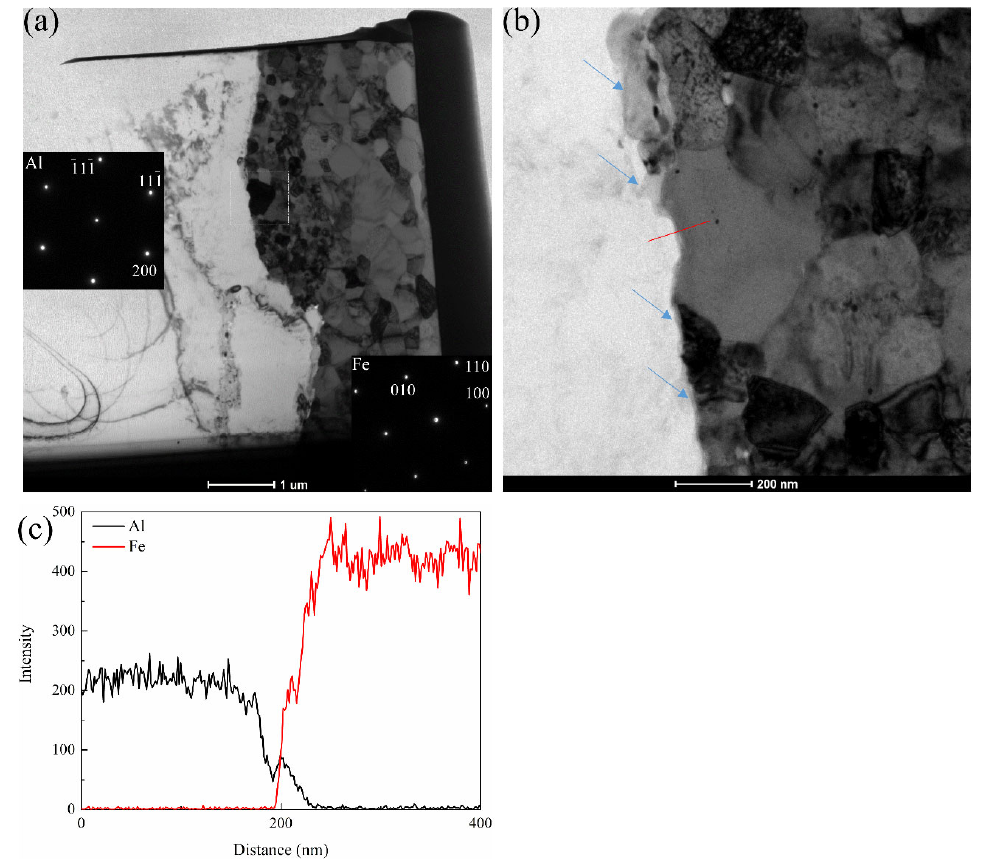
Figure 4. ( a ) TEM bright-field picture of the Al/steel bonding interface of the aged sample, ( b ) amplified interfacial structure from the dashed rectangle in ( a ), and ( c ) the EDS line scanning from the red line in ( b ).